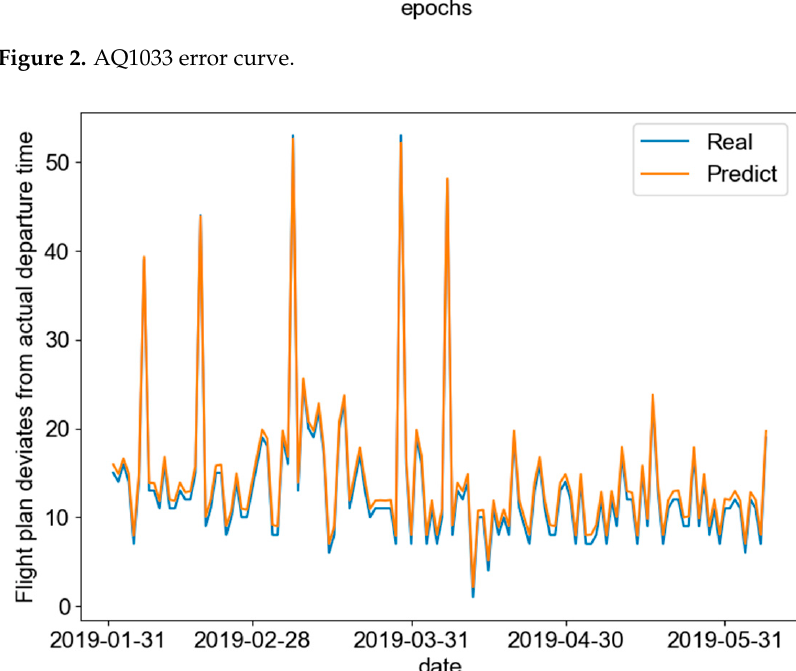
Figure 3. AQ1033 training set fitting graph.